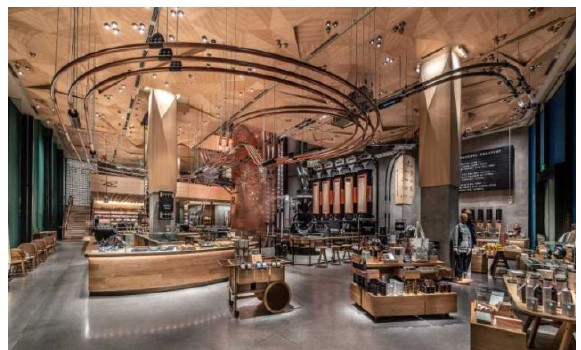
Figure 36. Starbucks Reserve Roastery in Seattle [86].